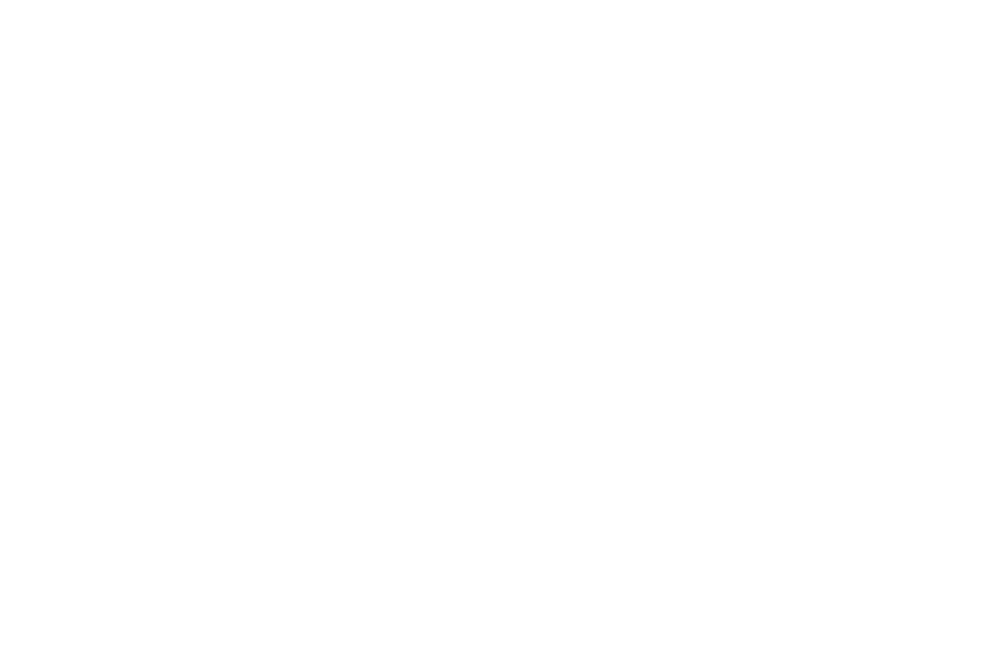
Figure A1 | Detailed behavioral results of the patient PS and each normal age-matched controls in the behavioral experiments (A). Accuracy and error rates for the face/non-face decision on Mooney stimuli (B) . Accuracy and error rates for the face/non-face decision on Arcimboldo stimuli (C) . PS ′ errors in the